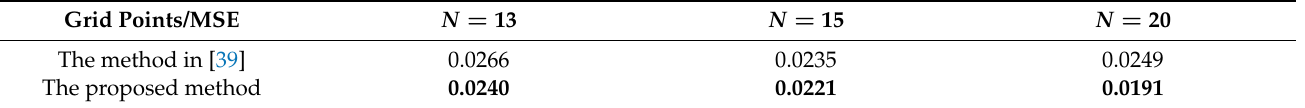
Figure 7. The beampattern matching performance comparison between the method in [39] and the proposed method with M = 10 antennas and a different number of grid points. Table 5. The corresponding MSE values between the proposed method and the method in [39] with M = 10 antennas and a different number of grid